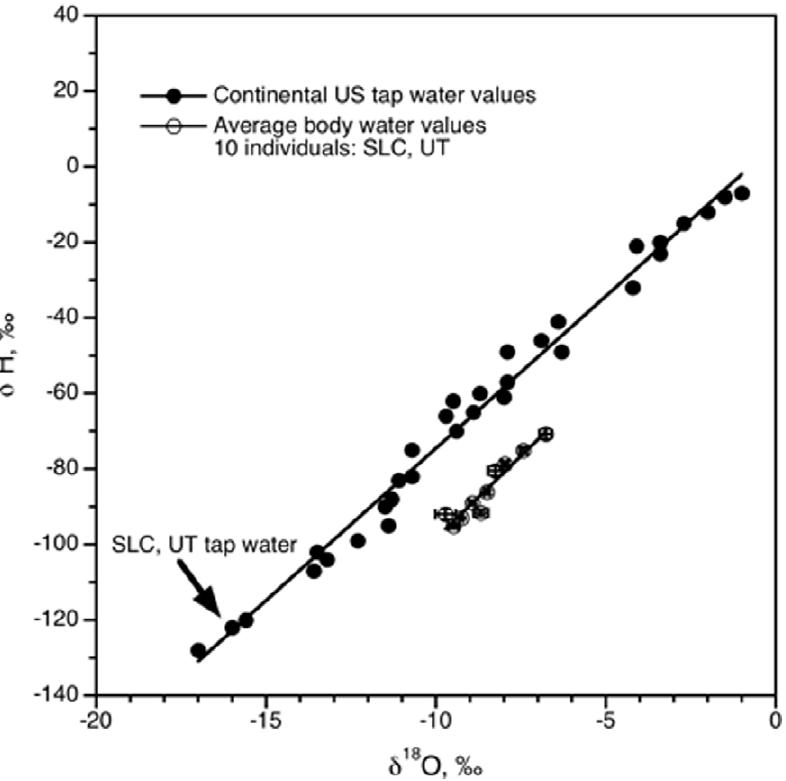
N Figure 1. Isotopic values of continental tap water relative to body water. Measured d 2 H and d 18 O values of tap water samples collected ) and body water (urine) samples collected within Salt Lake City, Utah ( # ). The simple linear from 18 states across the continental United States ( regression between the hydrogen and oxygen of tap water ( d 2 H=8.06 18 O + 6.15, r 2 =0.992) and body water ( d 2 H=8.91 d 18 O 2 9.72, r 2 =0.962) are also shown.